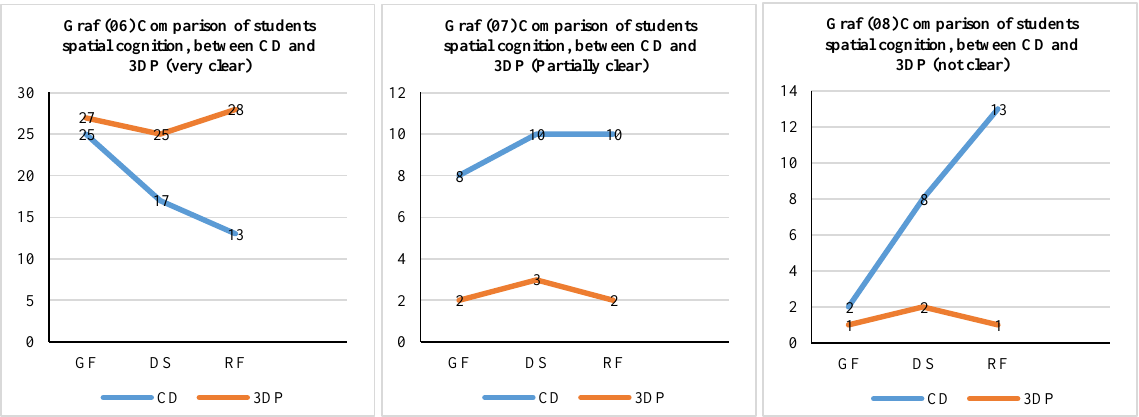
Figure 7. Comparison of CD and 3DP in Students’ spatial